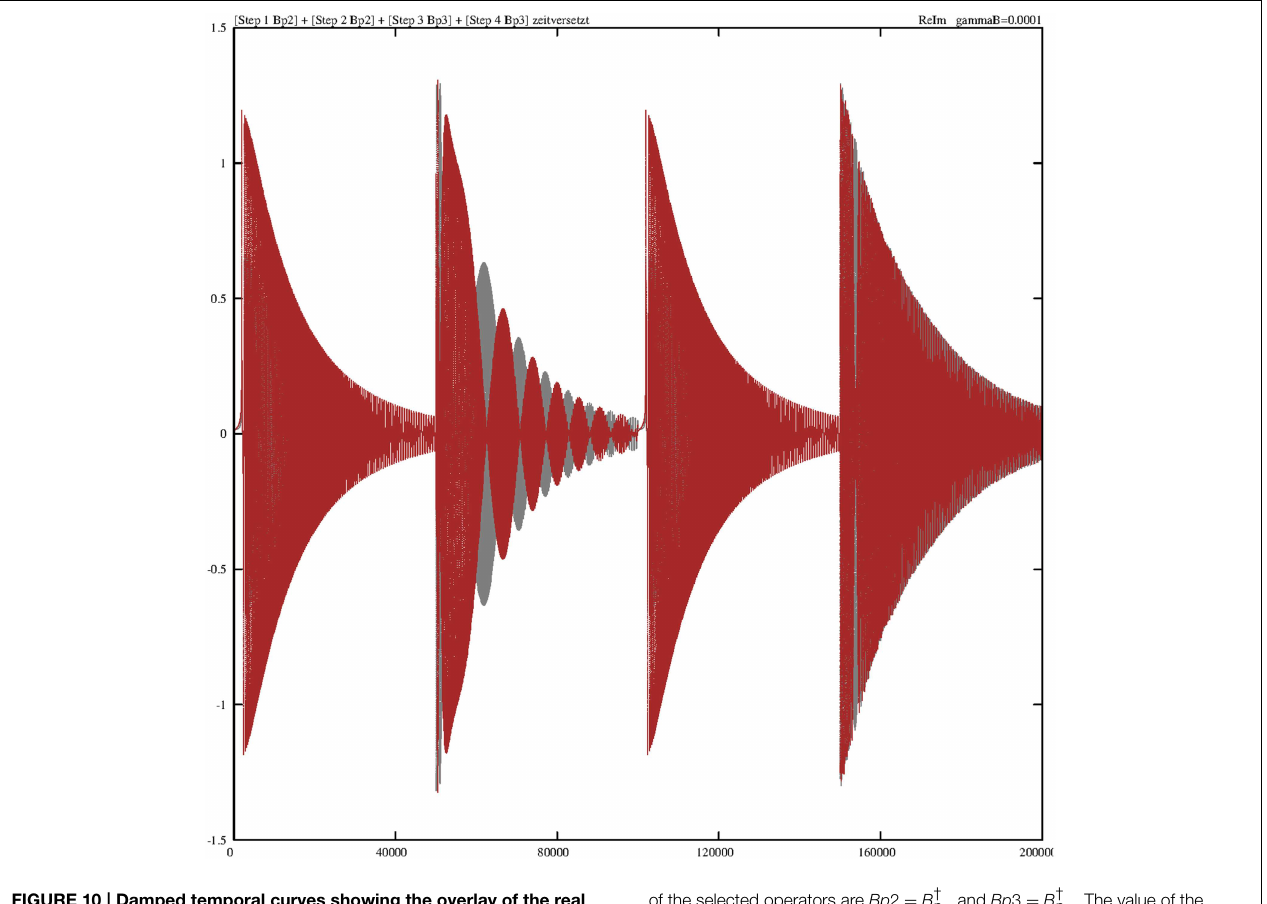
and B † p , which 2 3